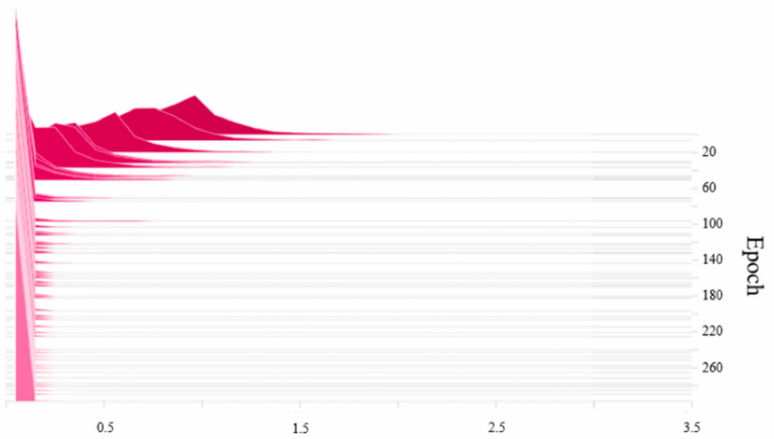
Figure 6. BN layer γ value distribution after the sparse training.